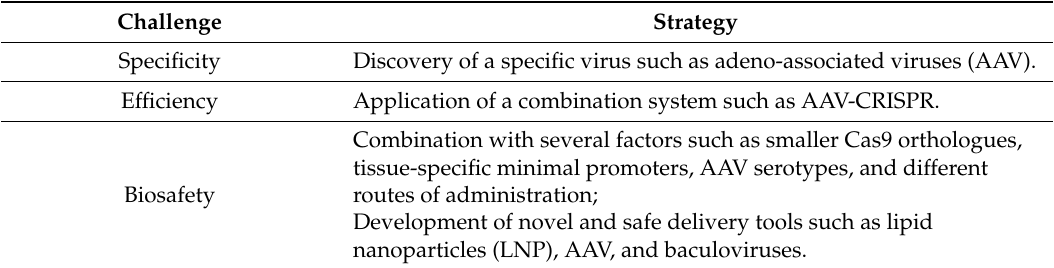
Table 3. Possible strategies for overcoming the challenges for CRISPR/Cas9 delivery. Challenge Strategy Specificity Discovery of a specific virus such as adeno-associated viruses (AAV). Efficiency Application of a combination system such as AAV-CRISPR. Combination with several factors such as smaller Cas9 orthologues, tissue-specific minimal promoters, AAV serotypes, and different routes of administration; Biosafety Development of novel and safe delivery tools such as lipid nanoparticles (LNP), AAV, and